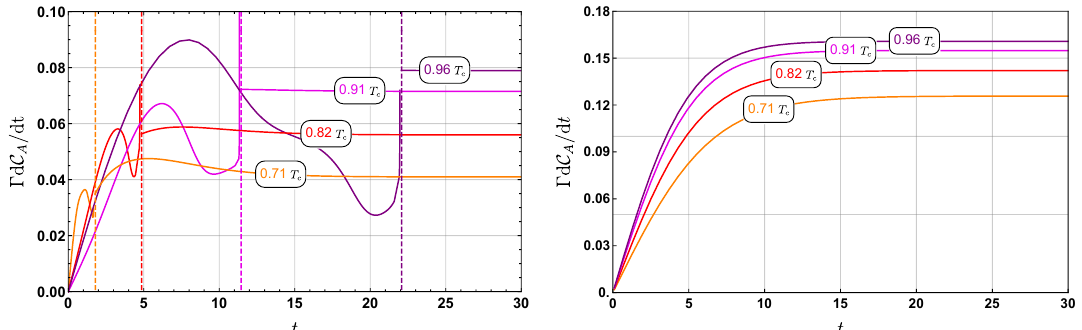
Figure 15 . The complexity growth rate of the superconducting phase for the negative critical time t c < 0 (left panel). The case for the normal phase at the same temperature is shown in the right panel. We choose Γ = 16 π 2 G Ω and µ = 1 N / 2